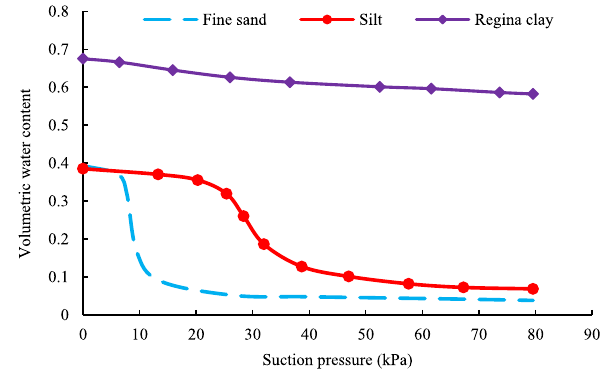
Fig. 20 Water retention curve for different soils (Lam et al, 1987)